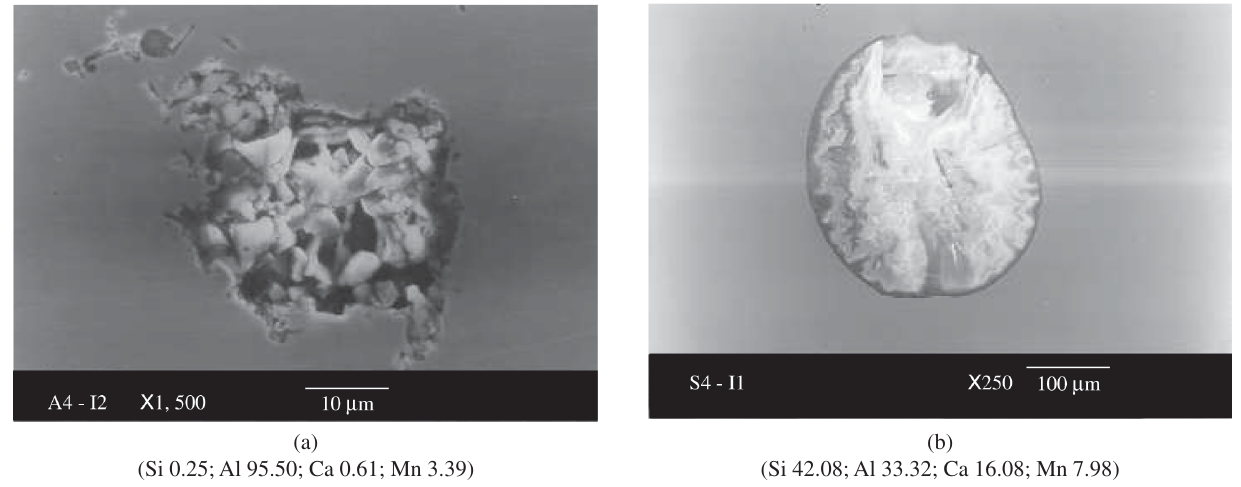
Figure 5. a) Inclusion from the sample of aluminum killed SAE 1010 steel; b) inclusion from the sample of silicon killed SAE 1005